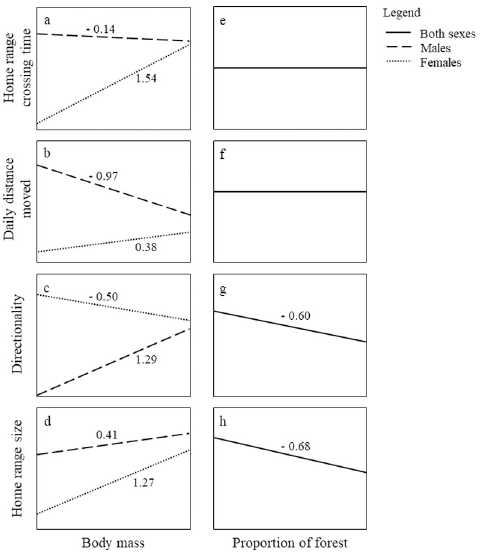
Fig 3. Graphical representation of the shape and direction of the effects of intrinsic and environmental traits on movement patterns and home range size of giant anteaters ( Myrmecophaga tridactyla ). Intrinsic traits are represented by sex and body mass. The environmental trait is represented by the proportion of forest cover within individuals’ home ranges. Movement patterns are described by home range crossing time, daily distance moved and directionality. Estimated coefficients are provided above tendency lines for each